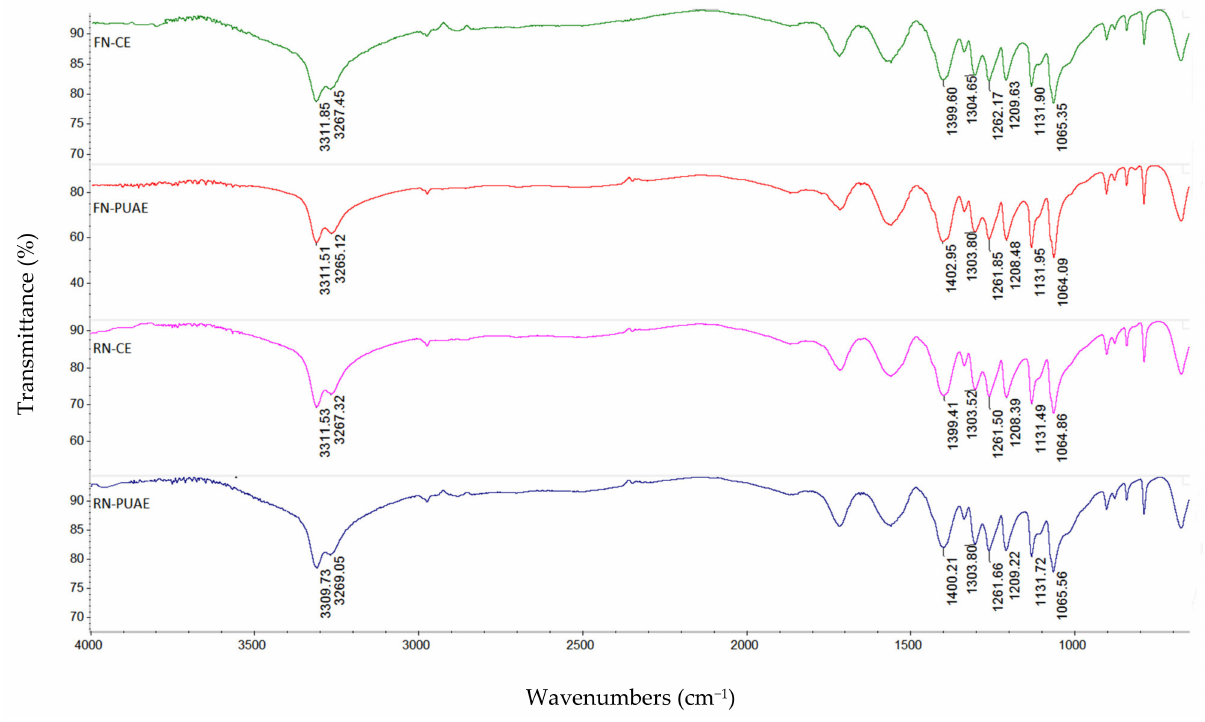
Figure 6. FT-IR spectra of pectin extracted from grape pomace (FN and RN) by CE and PUAE under the optimal